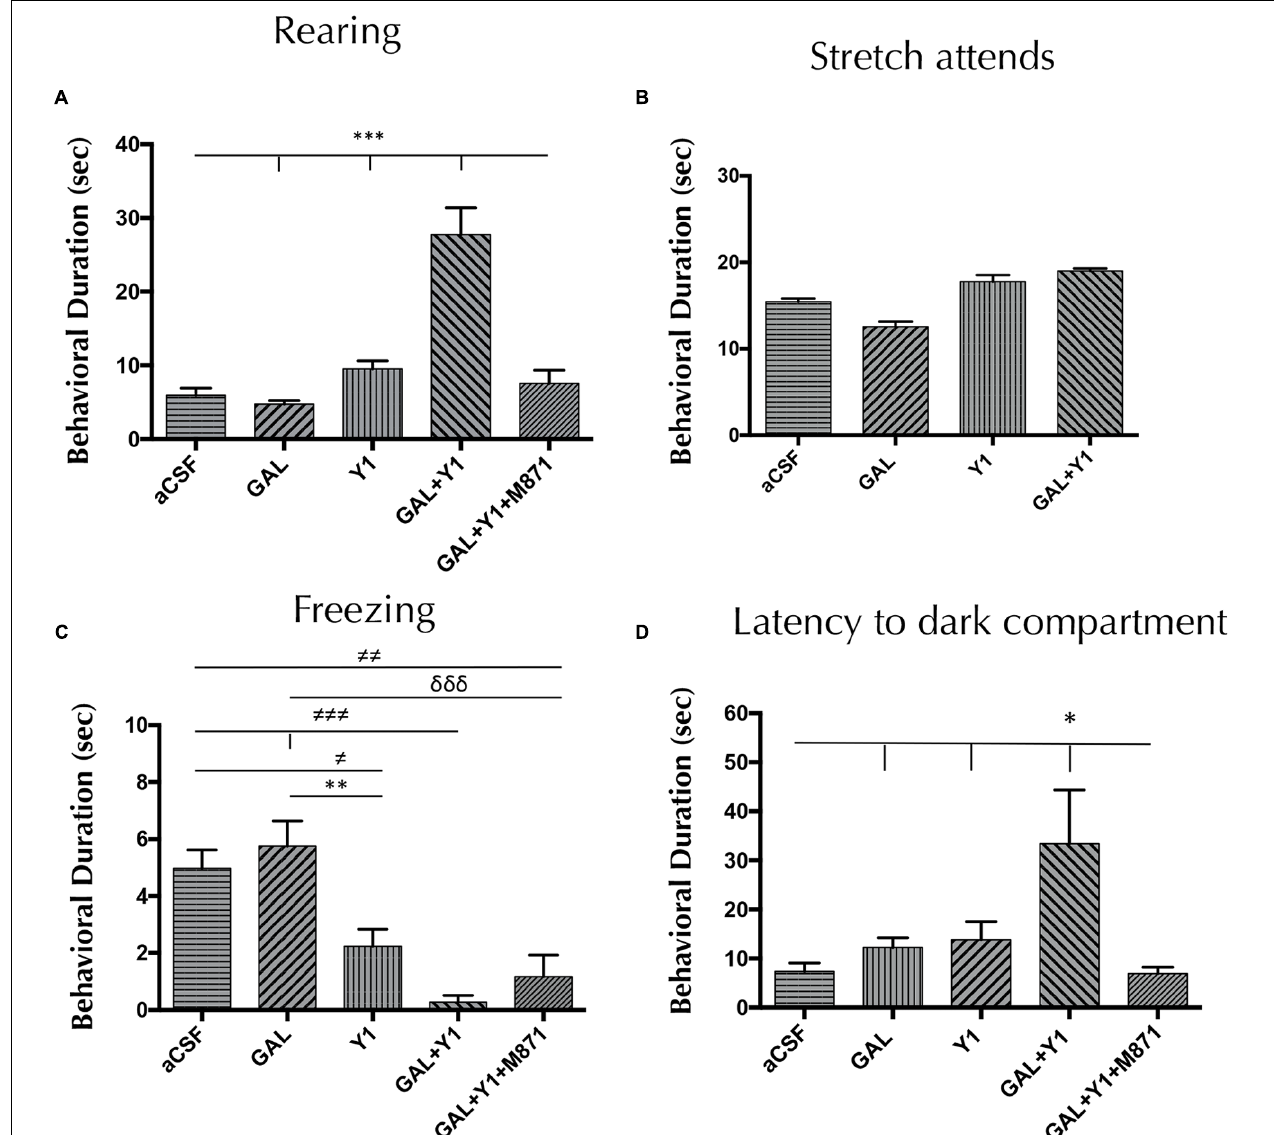
FIGURE 3 | Light-dark box behavioral analysis mediated by Galanin (GAL) and the NPYY1R agonist. The response induced by GAL on the NPYY1-mediated ethological behaviors is blocked by the GAL 2 receptor (GALR2) antagonist M871. Cumulative behavioral duration on rearings (A) , SAP (B), freezing (C) and latency to enter to the dark compartment (D) in the light-dark box. N = 6–8 animals in each test group. Data represent mean ± SEM. Value for GAL+Y1+M871 group on stretch attends was 16.3 ± 0.59. ∗ P < 0.05; ∗∗ P < 0.01; ∗∗∗ P < 0.001; (cid:54)= P < 0.05; (cid:54)=(cid:54)= P < 0.01; (cid:54)=(cid:54)=(cid:54)= P < 0.001; δδδ P < 0.0001 according to one-way ANOVA followed by Newman–Keuls Multiple Comparison Test. Inter-group comparisons are indicated by the lines above bars. GAL, Galanin 3 nmol; Y1, NPY Y1 receptors agonist [Leu 31 -Pro 34 ]NPY 3 nmol; GAL+Y1, Coadministration of GAL and Y1; GAL+Y1+M871, Coadministration of GAL, Y1 and GALR2 antagonist M871 3